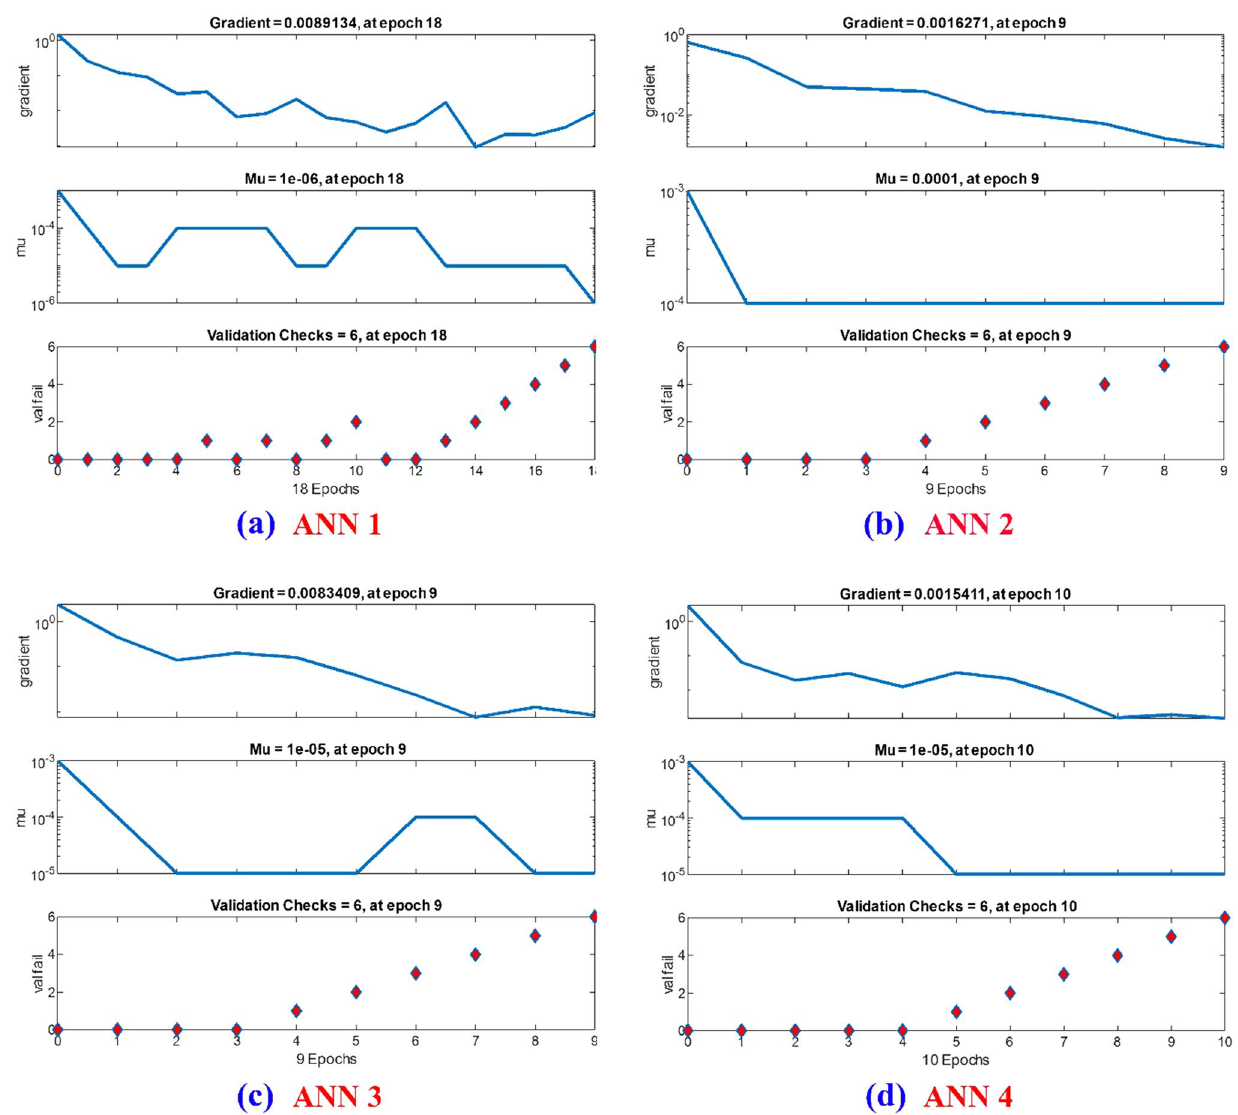
Fig. 20 The convergence history of the ANN models for liquefaction prediction, a Model No.1 (ANN 1), b Model No.2 (ANN 2), c Model No.3 (ANN 3), d Model No.4 (ANN